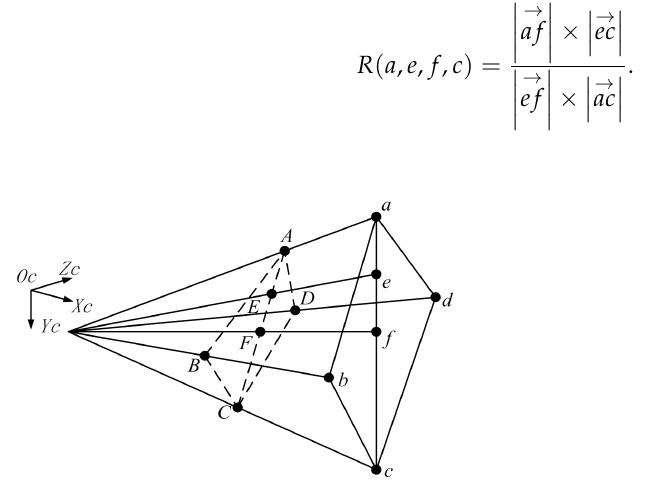
Figure 2. Cross-ratio